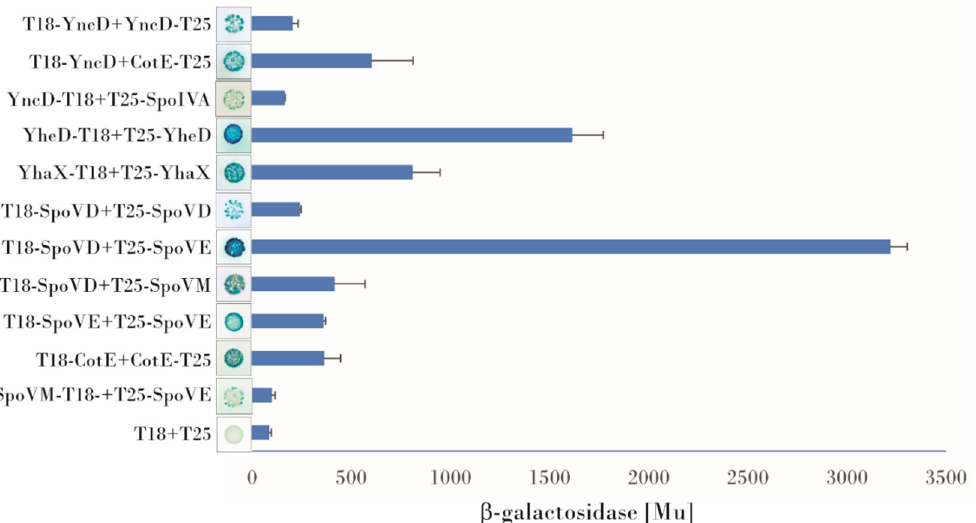
Figure 1. Bacterial two hybrid analysis of the interactions of spore proteins. The combinations of plasmids that provided the most intense signals on X-gal plates are shown. The β -galactosidase activity was determined as the average of at least three independent cell samples. All β -galactosidase values were subjected to the Dixon outlier test ( p < 0.01).